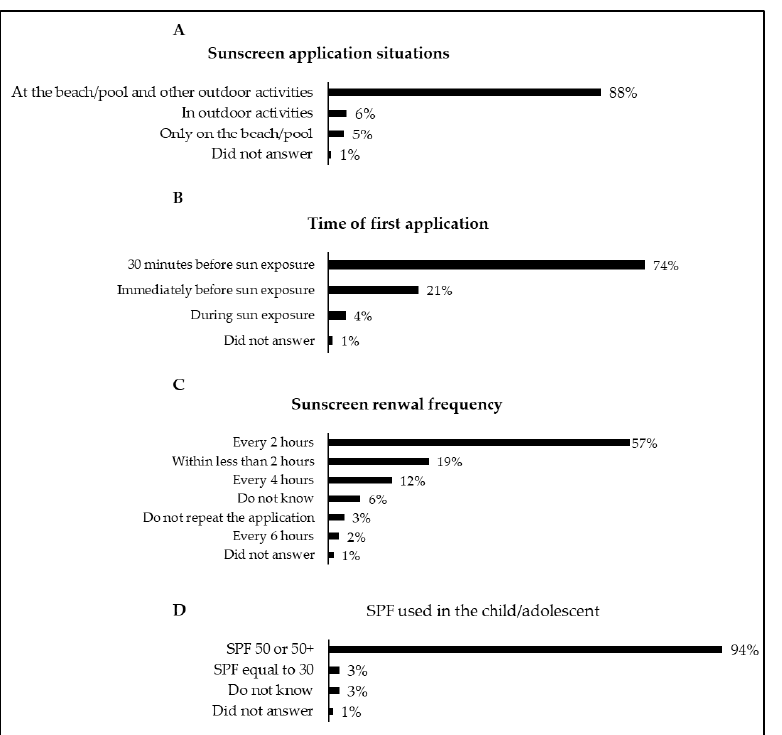
Figure 5. Frequency of use of sunscreen by the caregiver ( A ) and the child/adolescent ( B ). Figure 6 shows the data associated with the sunscreen application situations, the time of first application, the sunscreen renewal frequency, and the sun protection factor (SPF) used by the children/adolescents. Overall, 57% of caregivers reported a renewal sunscreen in the child/adolescent every 2 h, and 94% reported that the child/adolescent used an SPF ≥ 50.